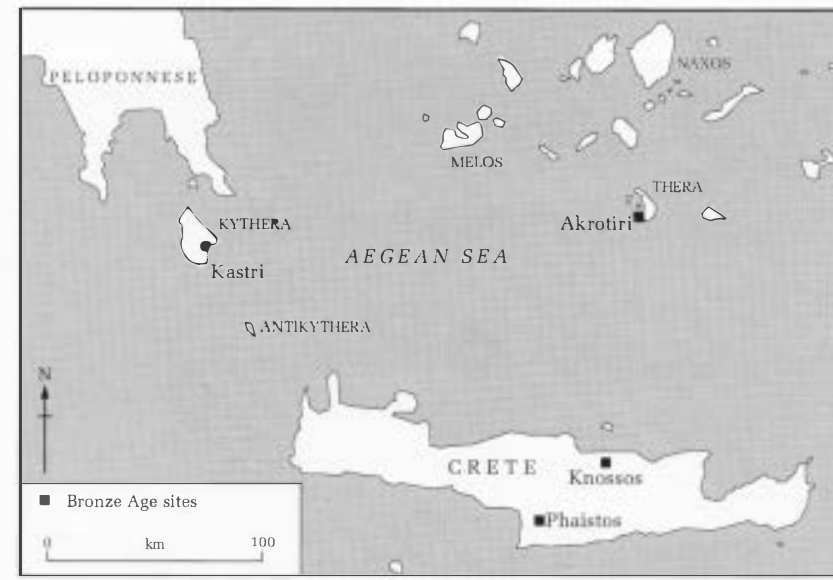
Figure 1 The southwestern Aegean, showing the location of the island of Kythera and the Bronze Age sites mentioned in the